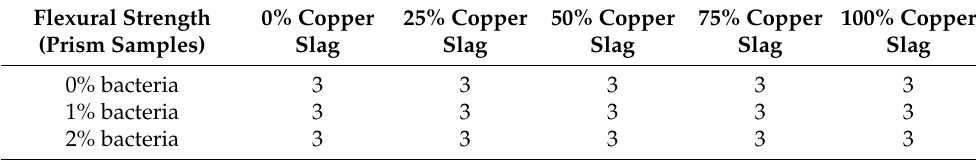
Table 7. Number of prism samples prepared for flexural strength evaluation on day 7.